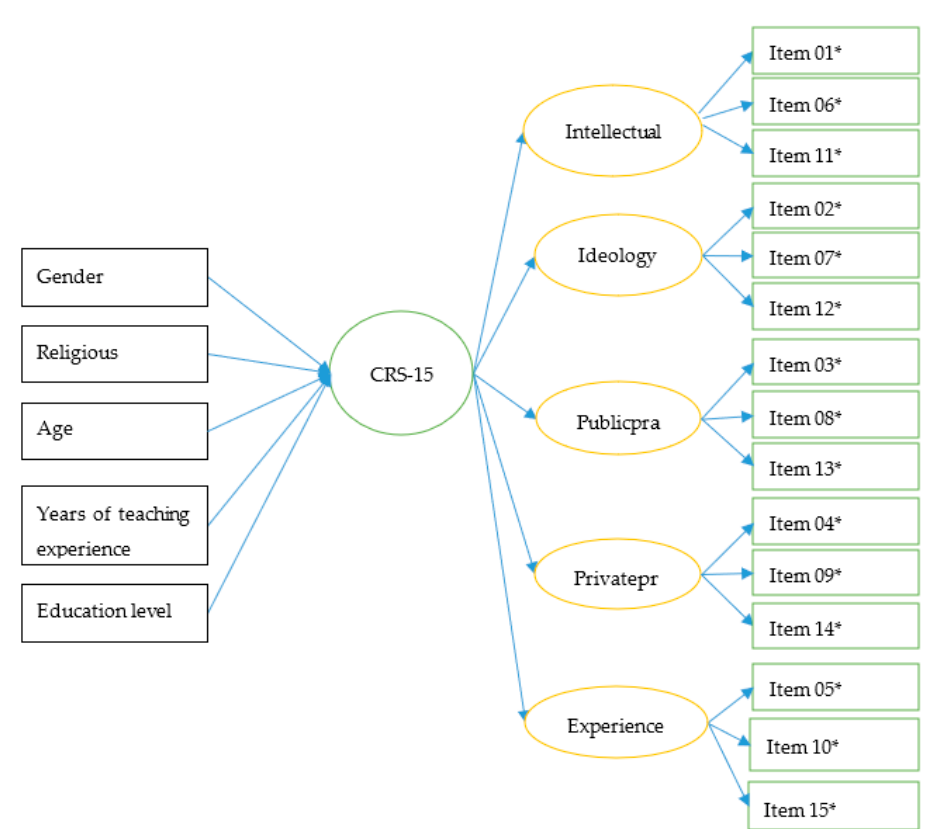
12 of 21 Figure A2. MIMIC model for CRSi-7; * Item 01 to Item 05 refer to Item 01-05 in Appendix D; *** p < 0.001; Pub1MAX*: The participants answered Item 04(How often do you pray?) and 04b (How often do you meditate?). However, only one answer is counted in the calculation of the score of the CRS,